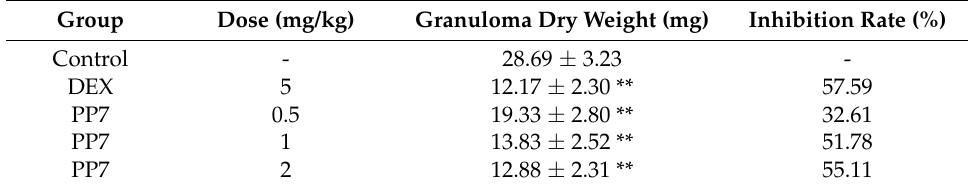
Table 2. Effect of PP7 on cotton pellet-induced granuloma in